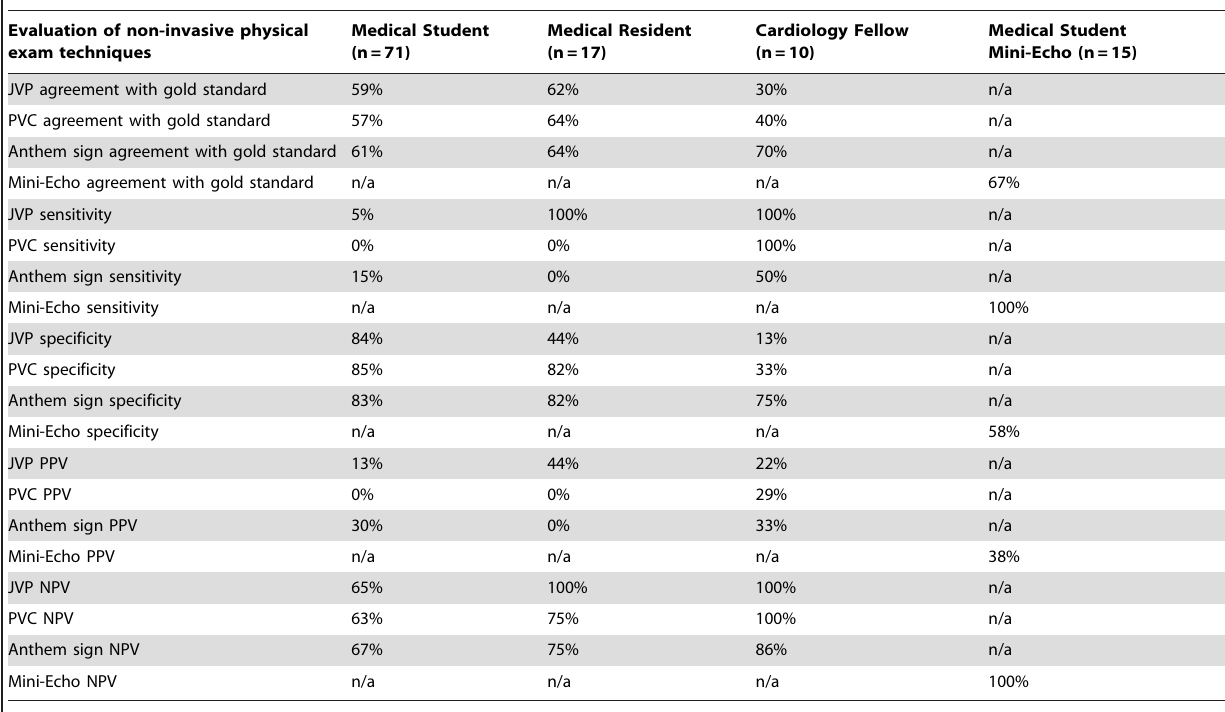
Table 3. Sensitivity and specificity of the physical exam techniques in the obese patients (BMI . 30 kg/m 2 ).